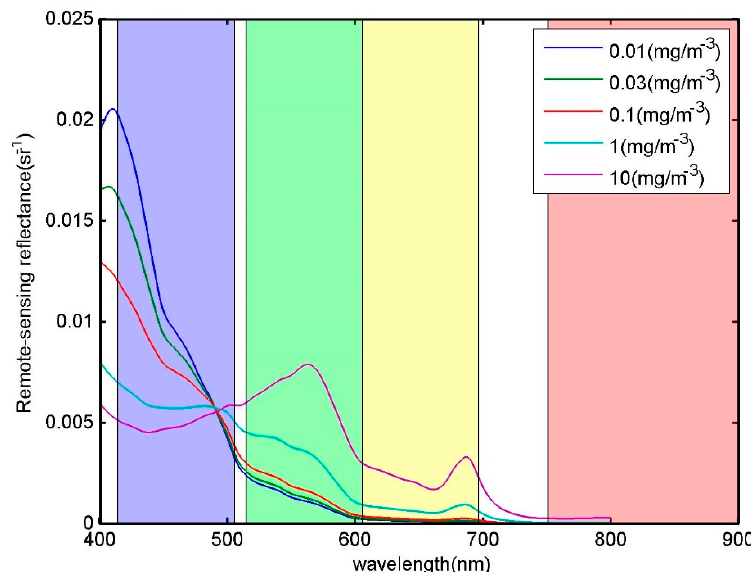
Figure 1. Spectral remote sensing reflectance R rs ( λ ) of Case 1 water, simulated by Hydrolight software under various chlorophyll a concentrations. The overlaid colored areas denote the four bands of CZI (Coastal Zone Imager), whose boundaries are determined by the 1% peak response.